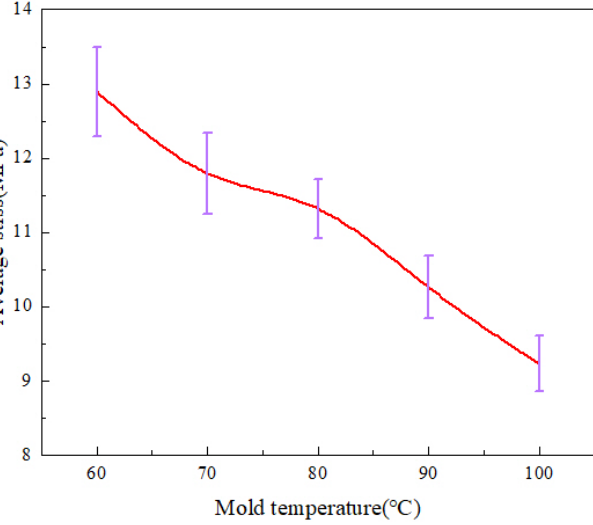
Figure 5. Variations of stress curve at different mold temperatures along the centerline of the parts.